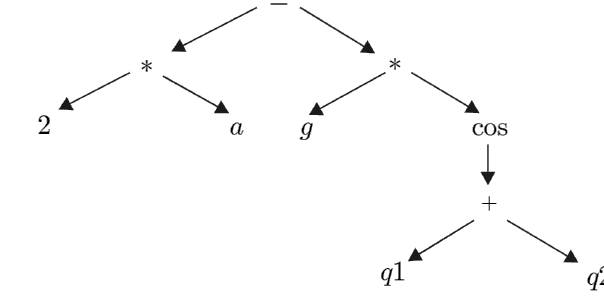
Figure 4. Tree representation of a mathematical